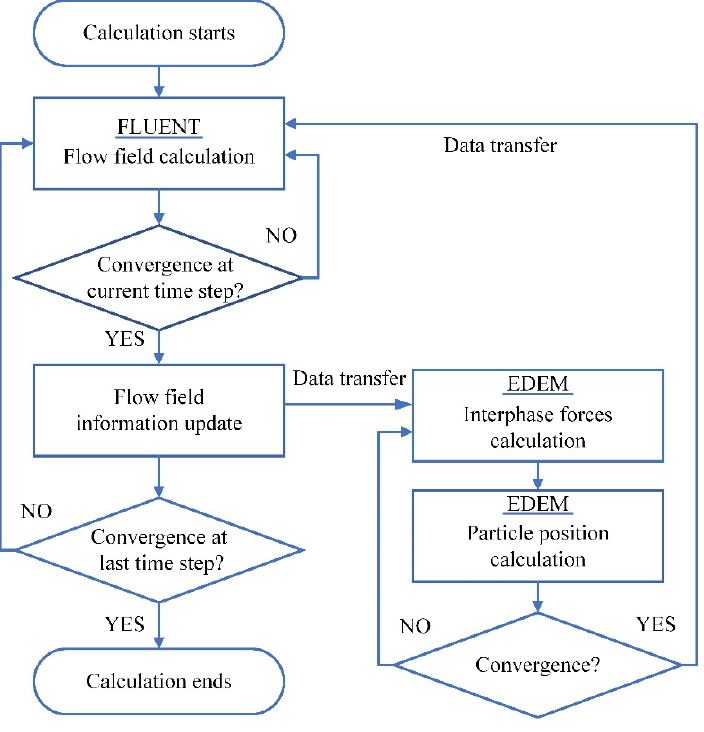
Figure 1. EDEM–FLUENT coupling process diagram.